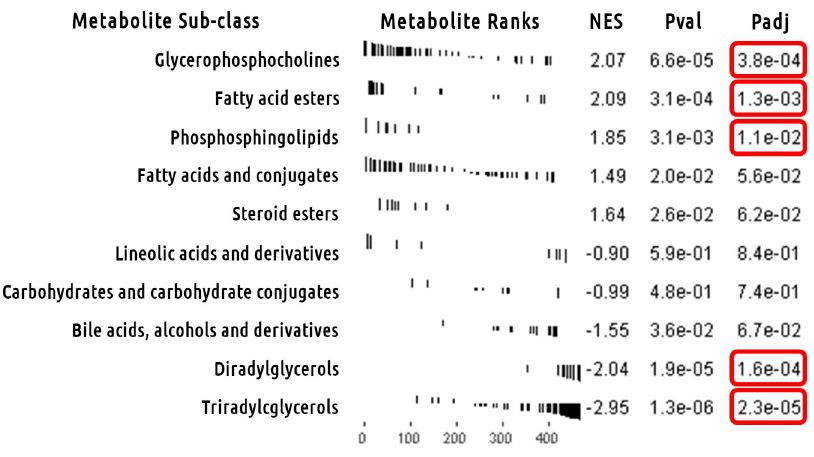
Fig 3. Metabolite set analysis of univariate model